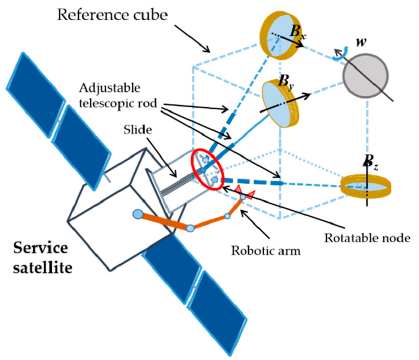
Figure 2. Diagram of service star structure.